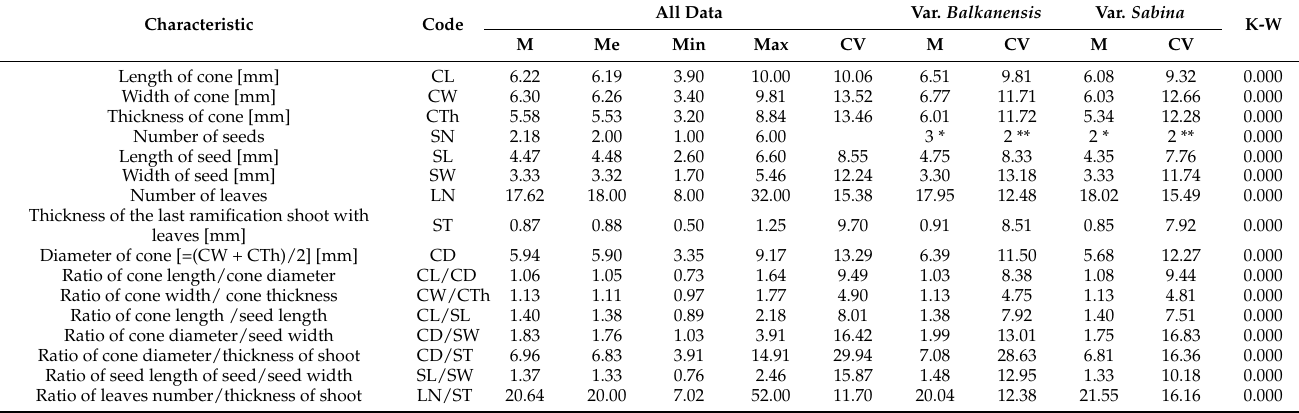
Table 2. Morphological characteristics of J. sabina cones, seeds and shoots, with codes and descriptive statistics. M— arithmetic mean, Me—median, Min—minimum value, Max—maximum value, CV—variation coefficient. K-W—significance of Kruskal-Wallis test for